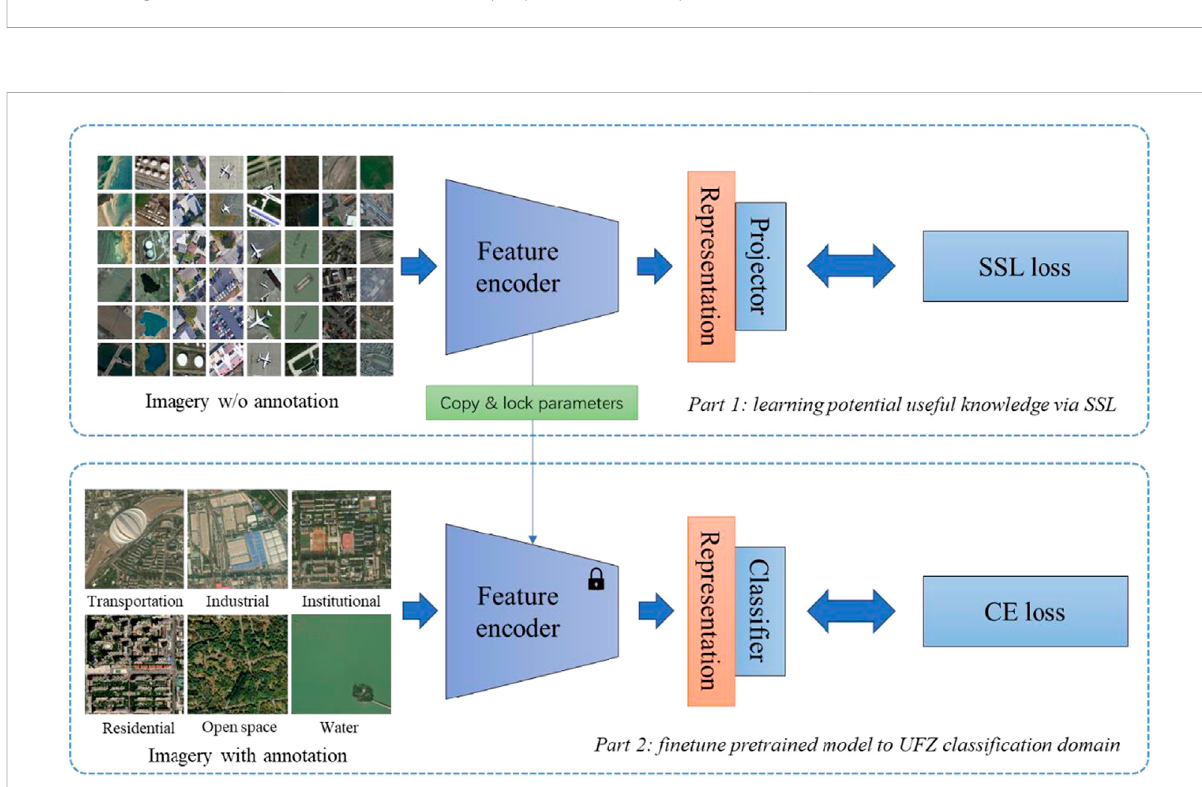
FIGURE 4 Flowchart of UFZ classi fi cation by